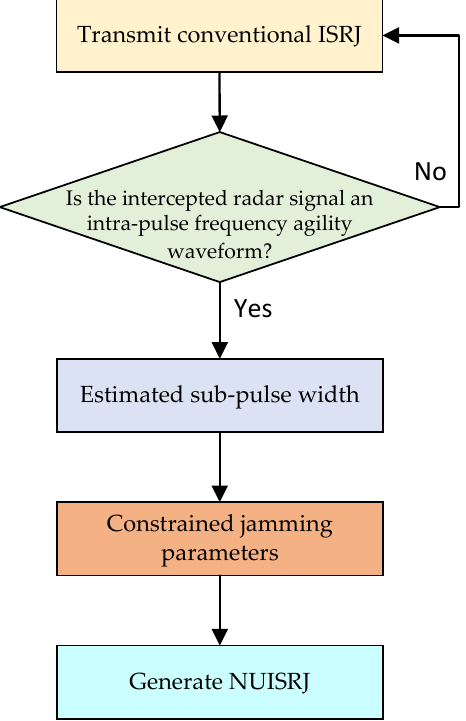
Figure 4. NUISRJ generation